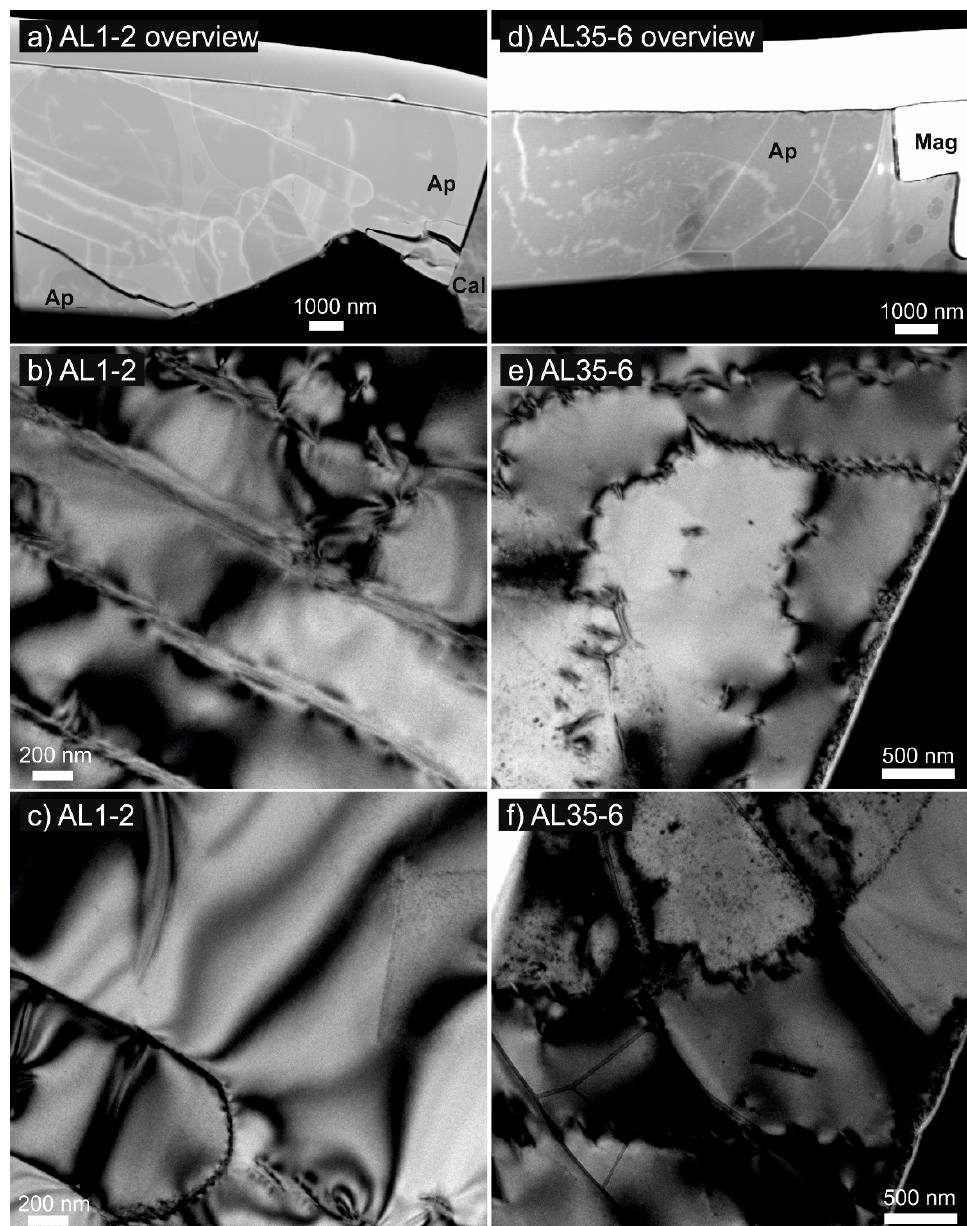
Figure 5. Overview HAADF and bright-field images of apatite subgrains separated by arrays of dislocations that form low-angle grain boundaries in crystals from mafic dyke AL1-2 ( a – c ) and BIF AL35-6 ( d – f ). Apatite crystals in the mafic dyke have straight parallel and simply curved ( b ) as well as strongly curved ( c ) low-angle grain boundaries. Overview images show abundant dislocations throughout the TEM foils. Ap—apatite, Cal—calcite,